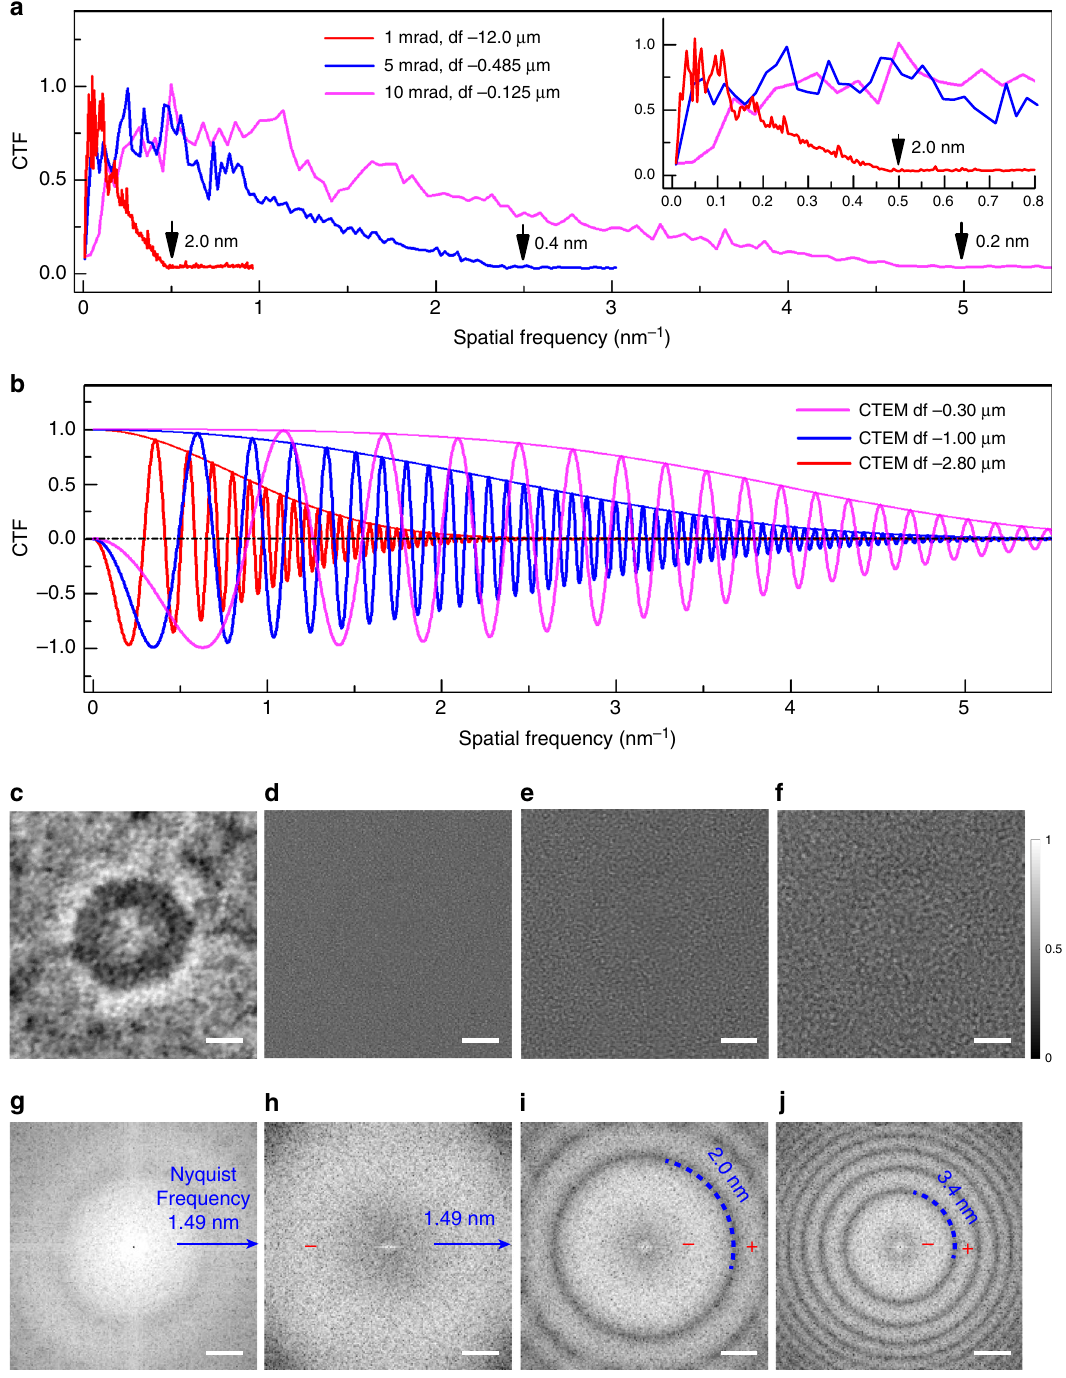
Fig. 2 CTFs and comparisons of ptychography and defocused TEM. a Simulated ptychographic phase CTFs for different convergence semi-angles with Poisson noise; 1 mrad (red line), 5 mrad (blue line), 10 mrad (magenta line) at an accelerating voltage of 80 kV. b Conventional phase CTFs of noise free for images simulated at different defoci: − 0.3 µ m (magenta line), − 1.0 µ m (blue line), − 2.8 µ m (red line) using envelope functions calculated according to refs. 54 – 56 at an accelerating voltage of 80 kV. c Experimental reconstructed ptychographic phase at dose of 146 e/Å 2 and TEM images at defoci of d − 0.32 μ m, e − 1.0 μ m, f − 2.8 μ m at dose of 180 e/Å 2 , of a resin embedded Adenovirus particle recorded at room temperature. For comparison,